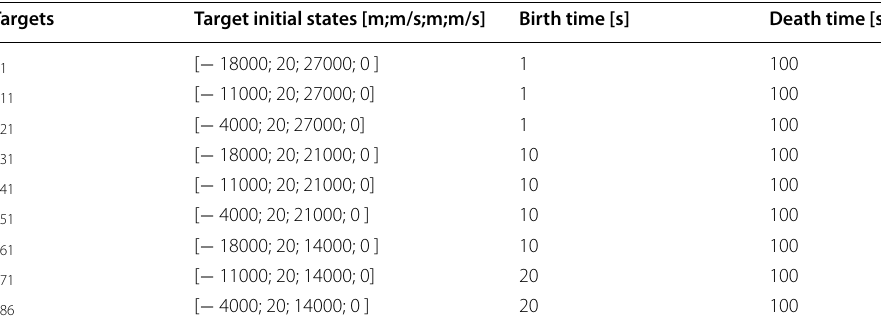
Table 1 Target initial states and birth/death time